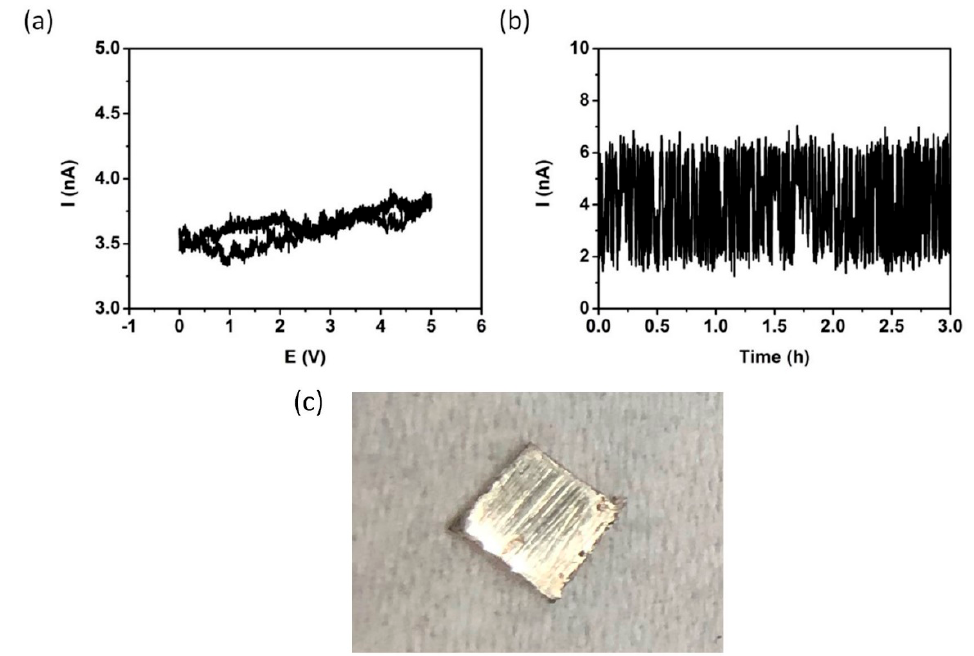
Figure 4. Stability of the micro-packaging. ( a ) Cyclic voltammetry. Scan rate: 20 mV / s ( b ) Potentiostatic test at 5 V. The voltage was applied over the stainless steel / tape / stainless sealing in a fully assembled dummy cell. ( c ) The lithium foil after storing inside a micro-package at ambient condition for two months.